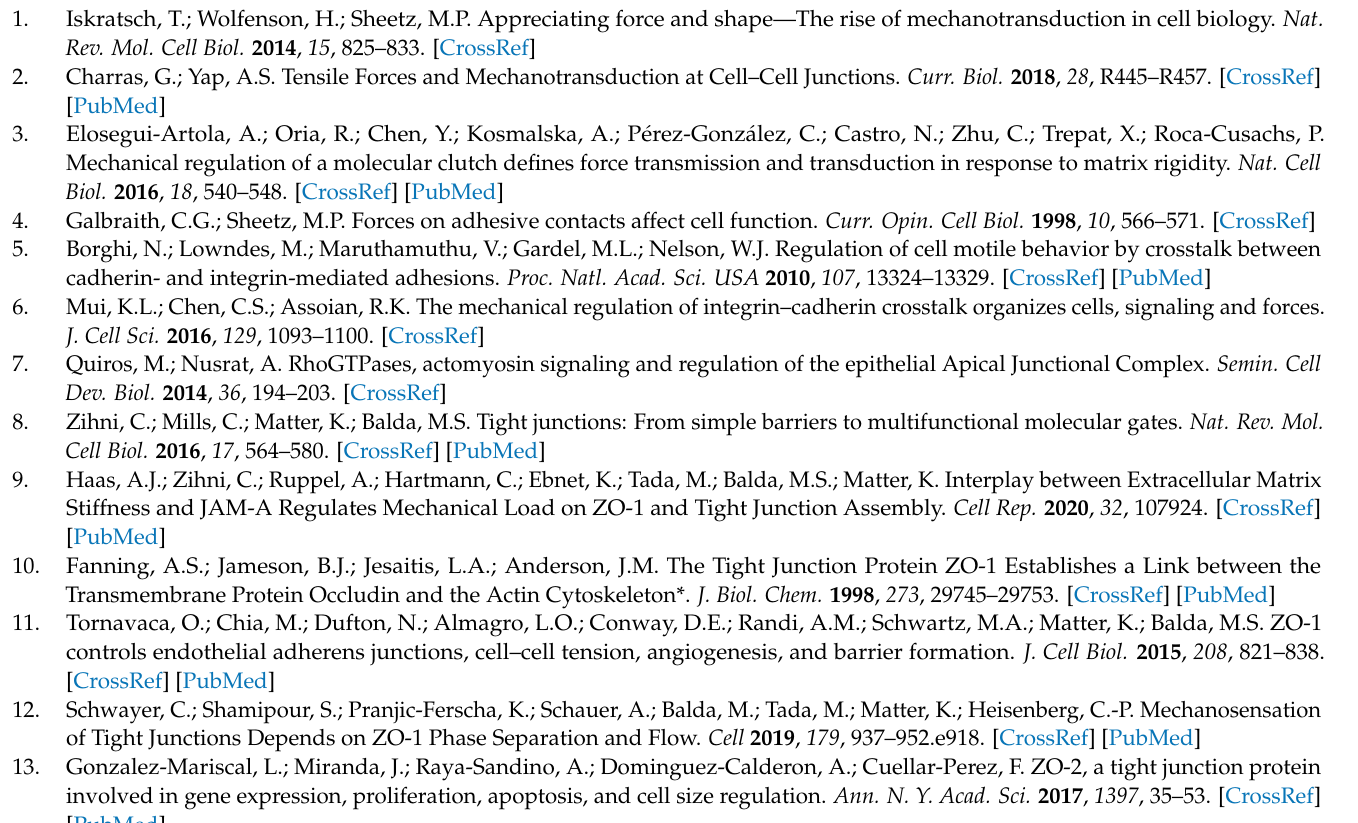
Figure S7: TJ assembly analysed in highly confluent cells; Figure S8: TJ assembly analysed in filter- grown cells; and Figure S9: TER development of ZO-1 KO cell